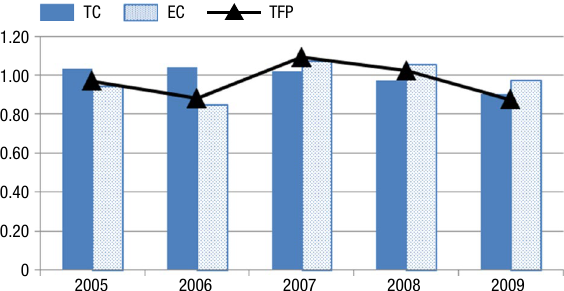
Fig. 3. The cumulative total factor productivity change in the crop farms, 2004–2009